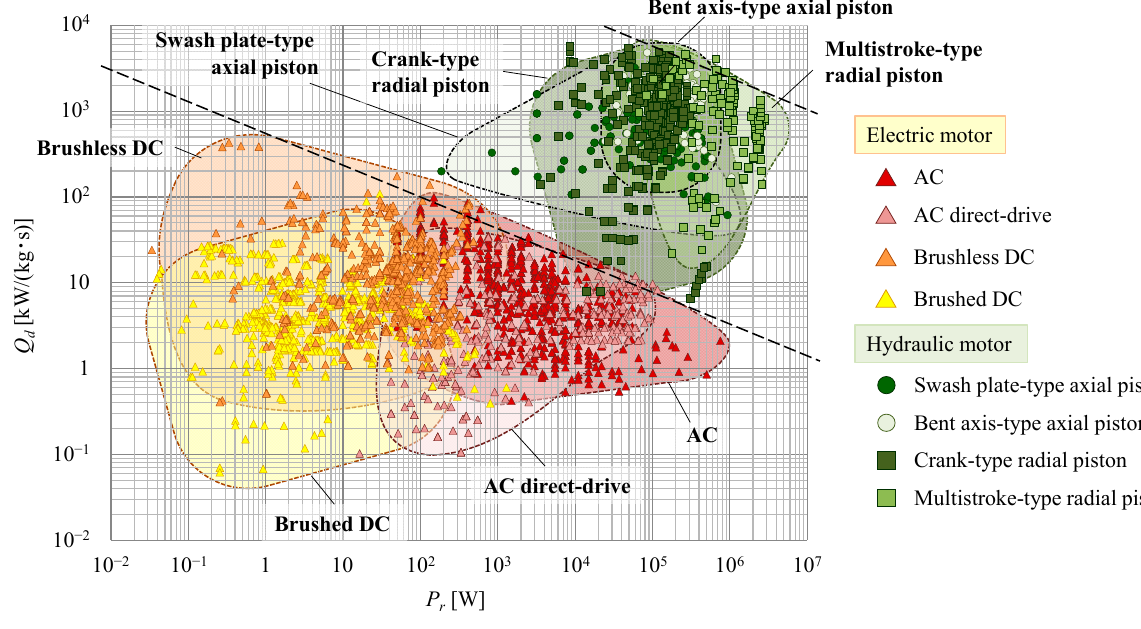
Figure 15. Correlation between rated output power and power rate density.